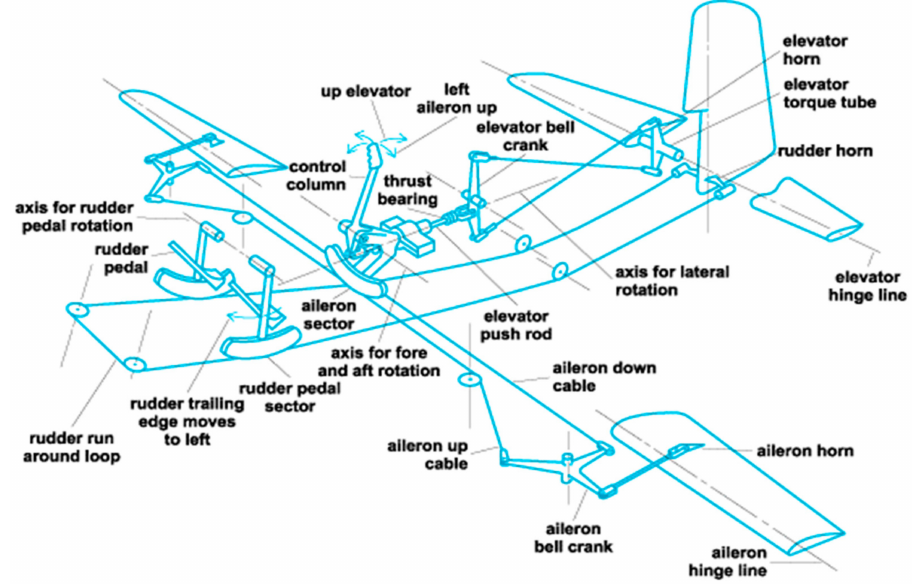
Figure 2. Mechanical flight-control actuation system showing structural parts